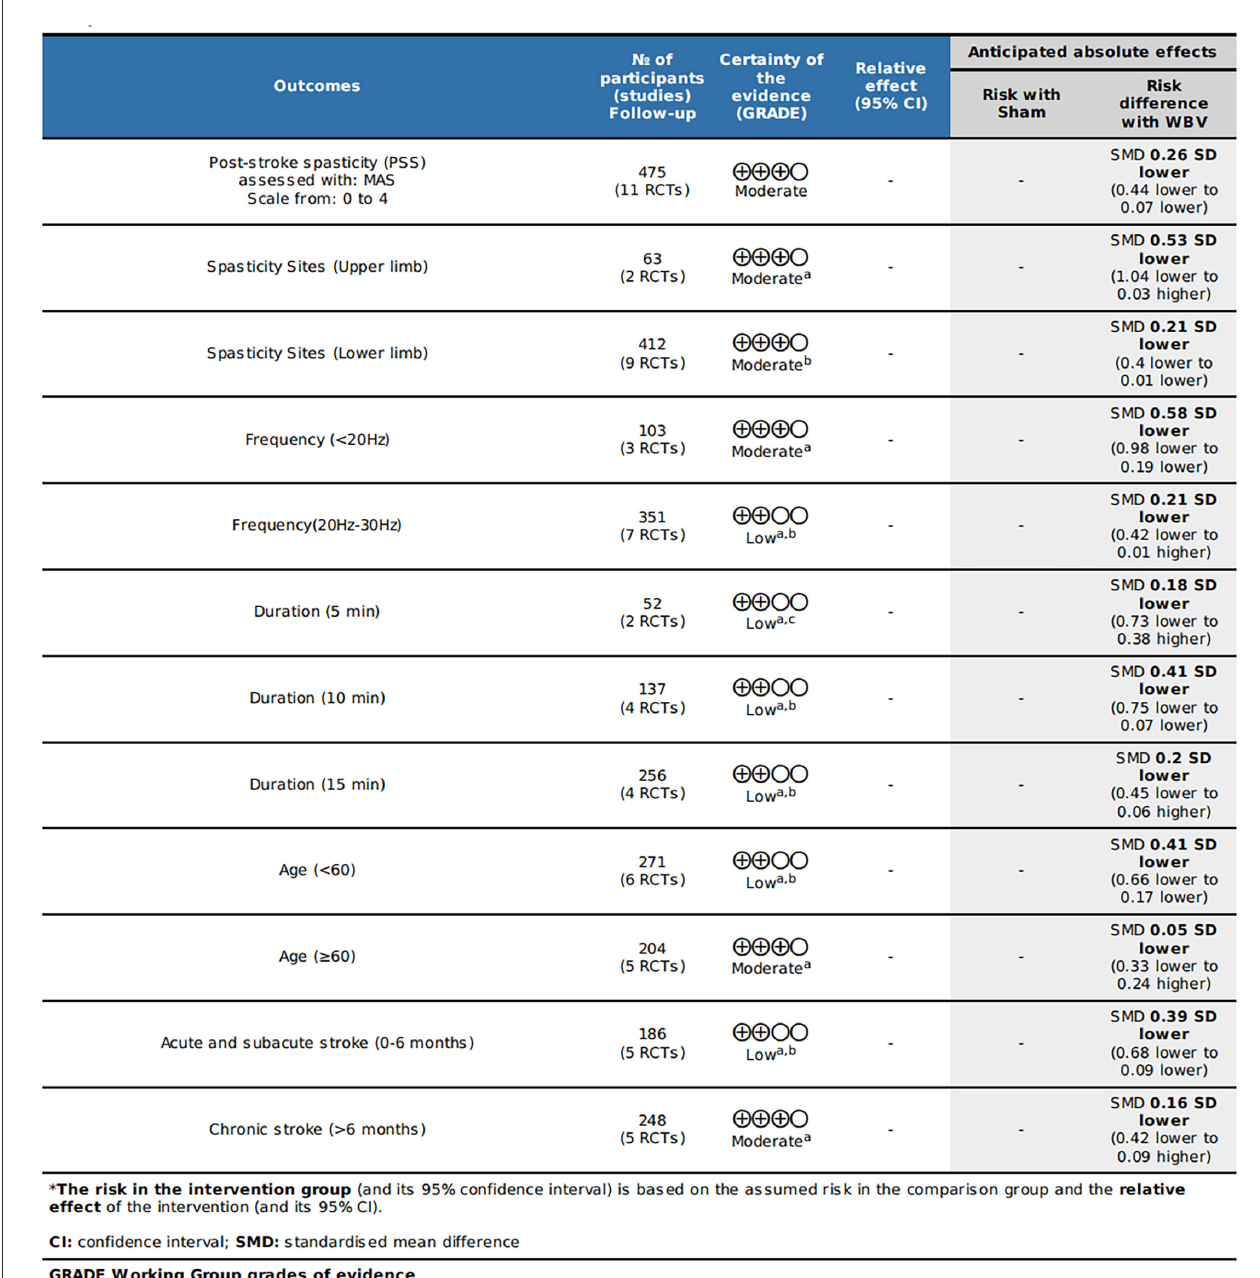
FIGURE2 Quality of evidence for the included studies (GRADE).